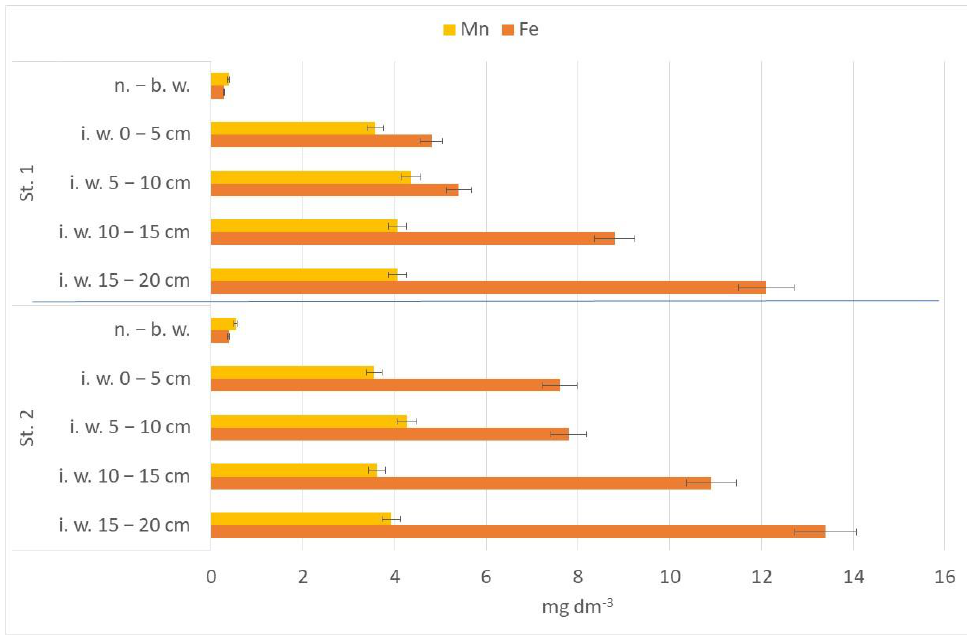
Figure 6. Manganese and iron concentration (±SD) in the near-bottom and pore water of Lake Kortowskie.